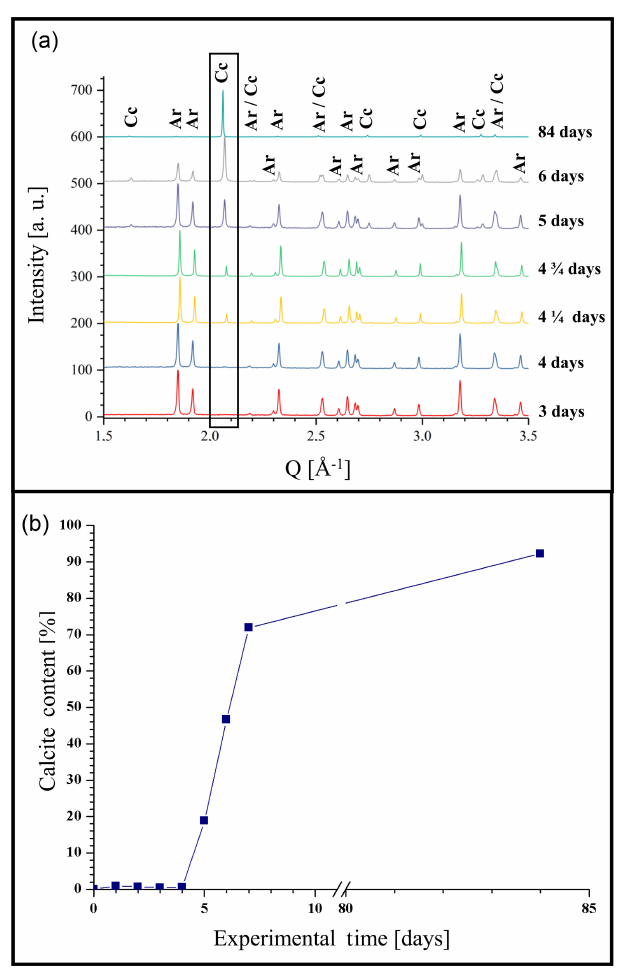
Figure 8. (a) Selected X-ray diffractograms for 3 to 84 days of al- teration of Arctica islandica shell material. Alteration took place in artificial burial solution at 175 ◦ C. (b) Newly formed calcite content relative to alteration time (days) calculated from Rietveld analyses of the XRD